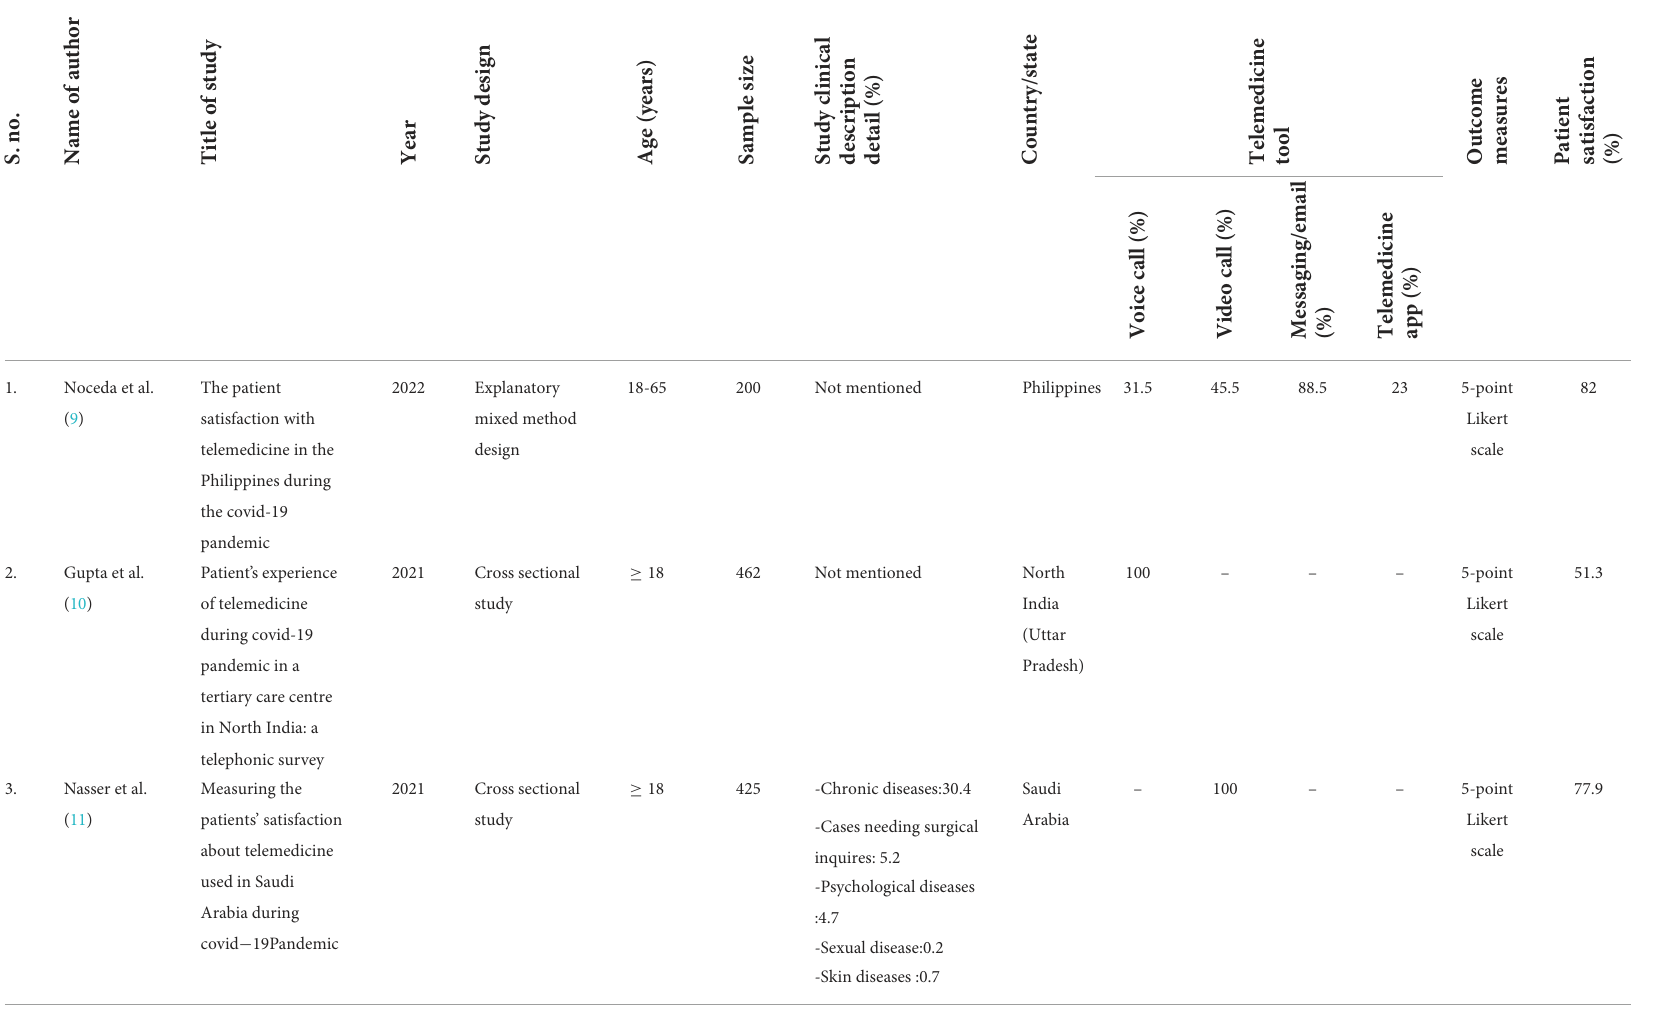
TABLE 2 Detail characteristics of study included in the